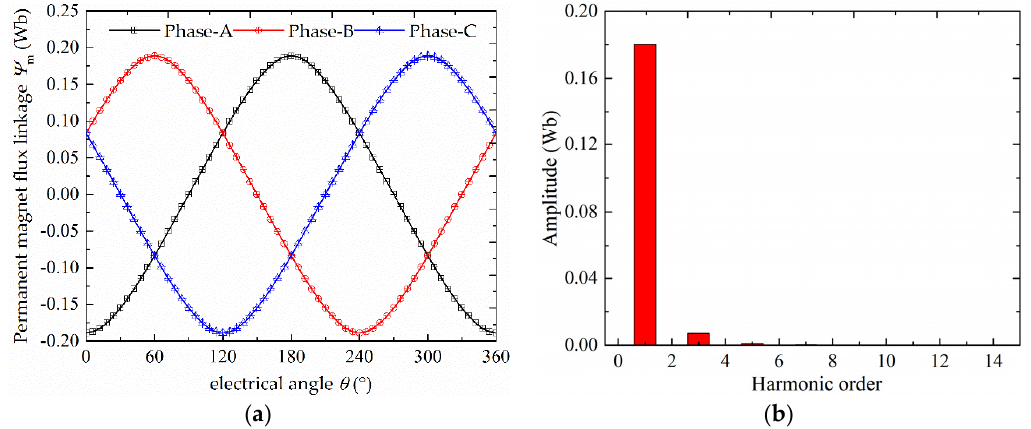
Figure 7. The permanent magnet flux linkage of CS-TFM: ( a ) waveform; and ( b ) Harmonic components.